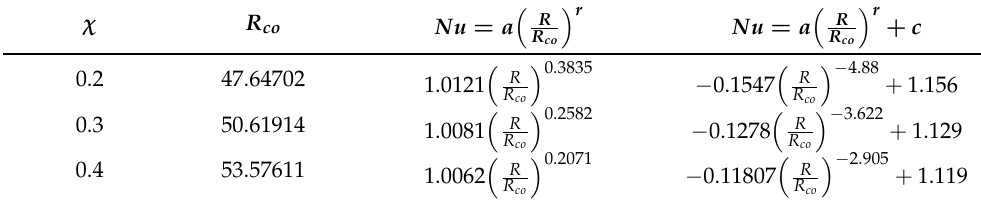
Table 3. Power law equations for different χ